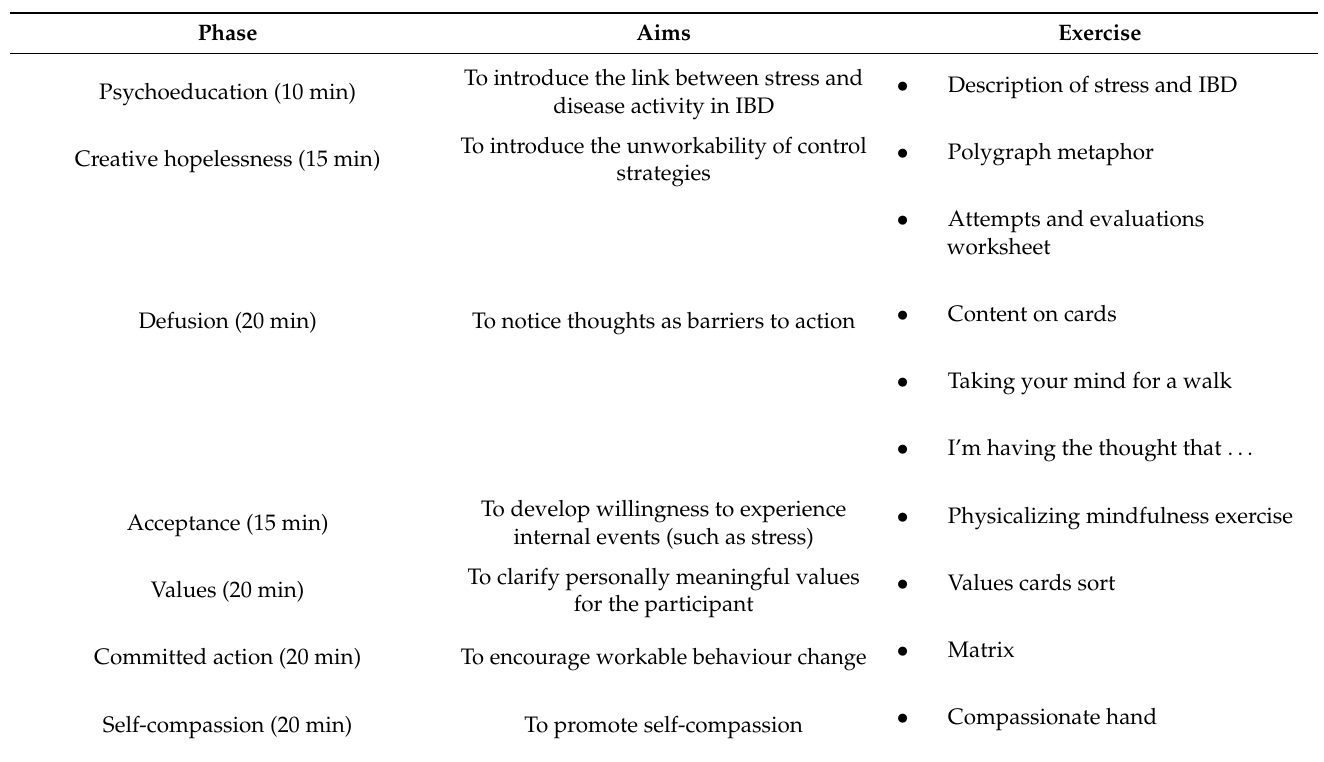
Table 2. Summary of single-session ACT intervention